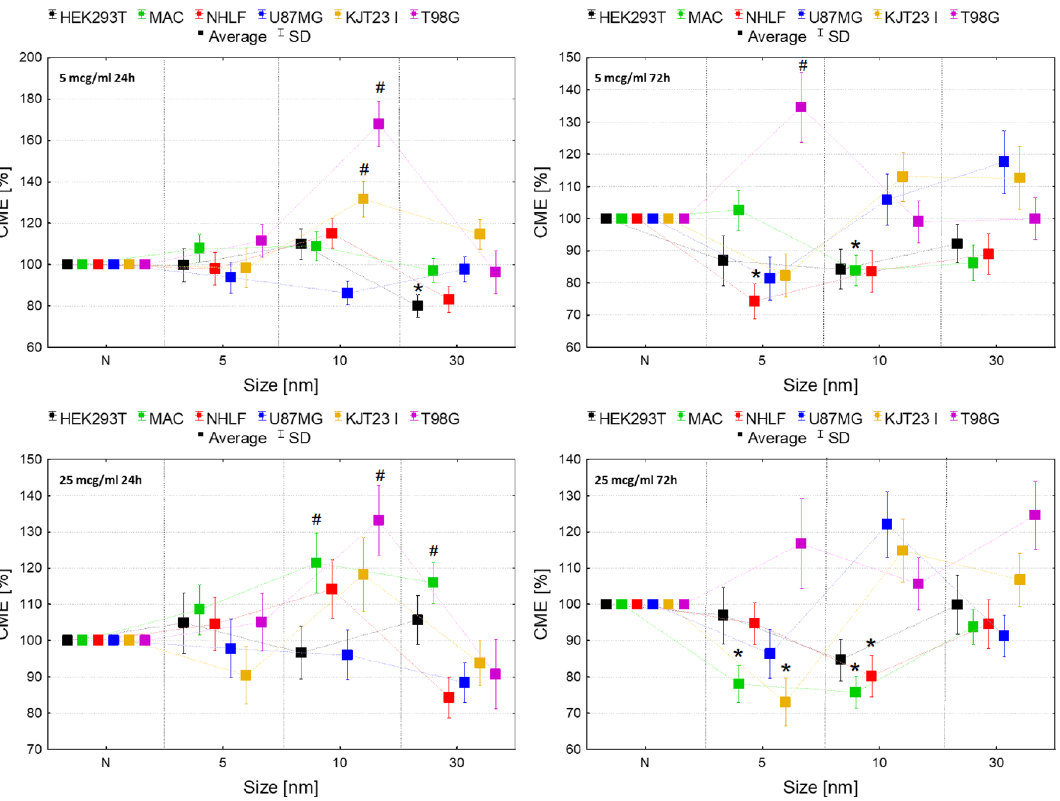
Figure 5. Normalized CME coefficient values after 24 and 72-h exposure to IONPs with the diameter of 5 nm, 10 nm and 30 nm in the concentrations of 5 µg Fe/ml and 25 µg Fe/ml comparing to the control group (N). The statistically significant ( p < 0.05) increases of CME compared with corresponding N group were marked with “#” while decreases with “*”. The scales were adjusted for each chart so that data presented are the most legible.